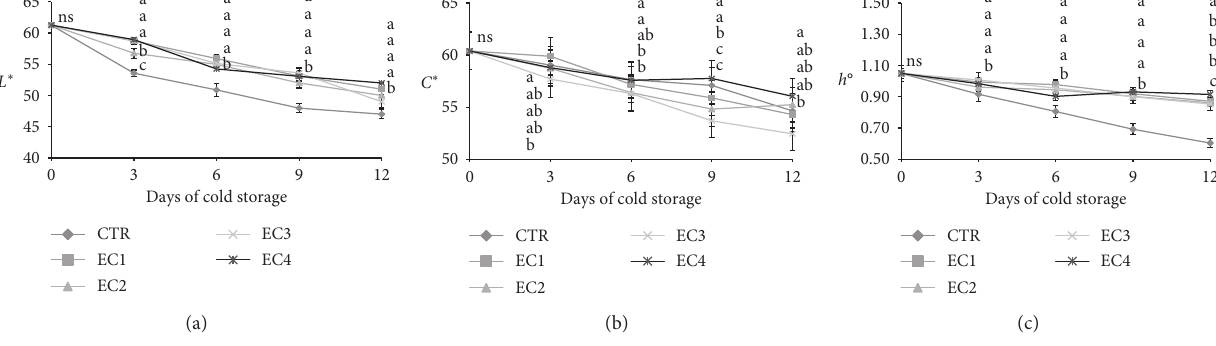
Figure 3: Brightness ( L ), chroma ( C ), and hue angle ( h ° ) trends of papaya fresh-cut fruits during storage at 5 ° C and 90% RH. Significant values are indicated with equal letters in each step.